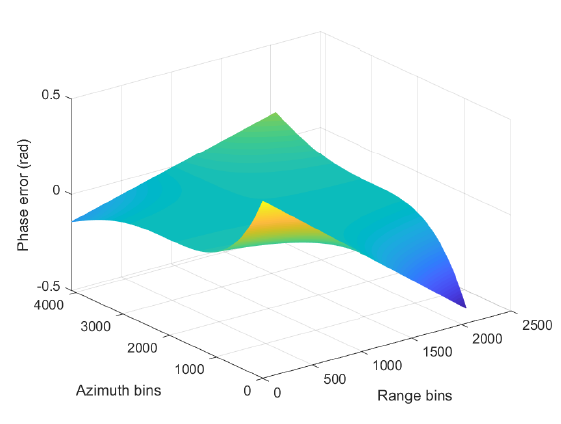
Figure 3. Phase error